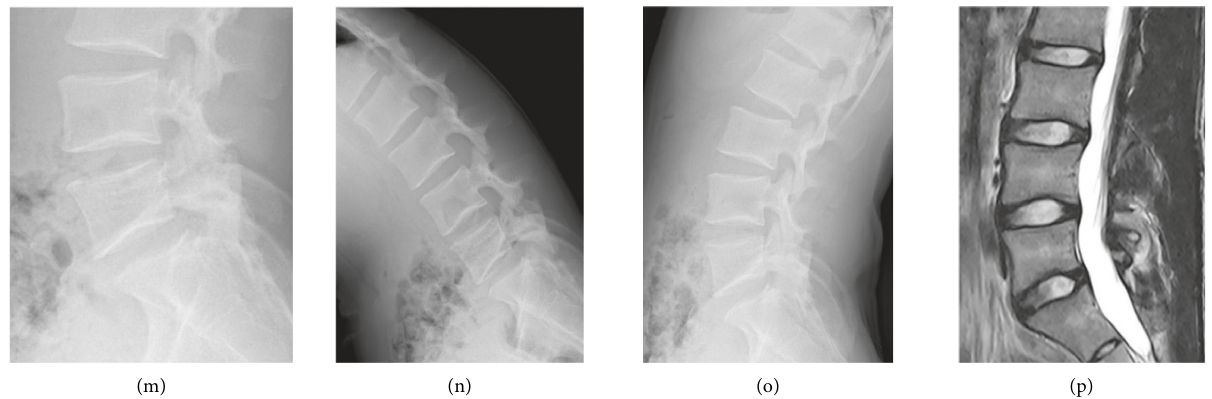
Figure 1: A 16-year-old male patient with LGIS of L5 had LBP of 7 points (VAS scores), without sciatica pain, and underwent direct pars repair using the PSRH system. (a)–(f) The X-rays of the lumbar spine in anteroposterior, sagittal, hyperextension and flexion, and double oblique positions, suggesting LGIS of the L5 with isthmic defect. The disc height and ROM of L5-S1 are 12.95mm and 23.9 ° , respectively. (g) The surgical segment and the upper segment are both grade 2 of Pfirrmann’s criteria by magnetic resonance imaging (T2-weighted MRI). (h)-(i) The postoperative X-rays, indicating that the isthmic defect has been repaired and lumbar 5 spondylolisthesis has been reset. (j) CT scan of the lumbar spine 12 months after surgery, showing that the isthmic defect has bony fusion. (k)-(l) X-ray films of hyperextension and flexion before removal of internal fixation at 42 months after the operation. (m)–(o) Re-examinations of the lumbar spine X-ray at 78 months after the operation, suggesting that the internal fixation has been removed. The disc height and ROM of the affected level were 10.6mm and 16.6 ° , respectively, and the ROM of the upper segment was 12.10 ° . (p) The lumbar spine MR at the FFU was grade 1 for the L4-5 discs and grades 2-3 for L5-S1 discs.